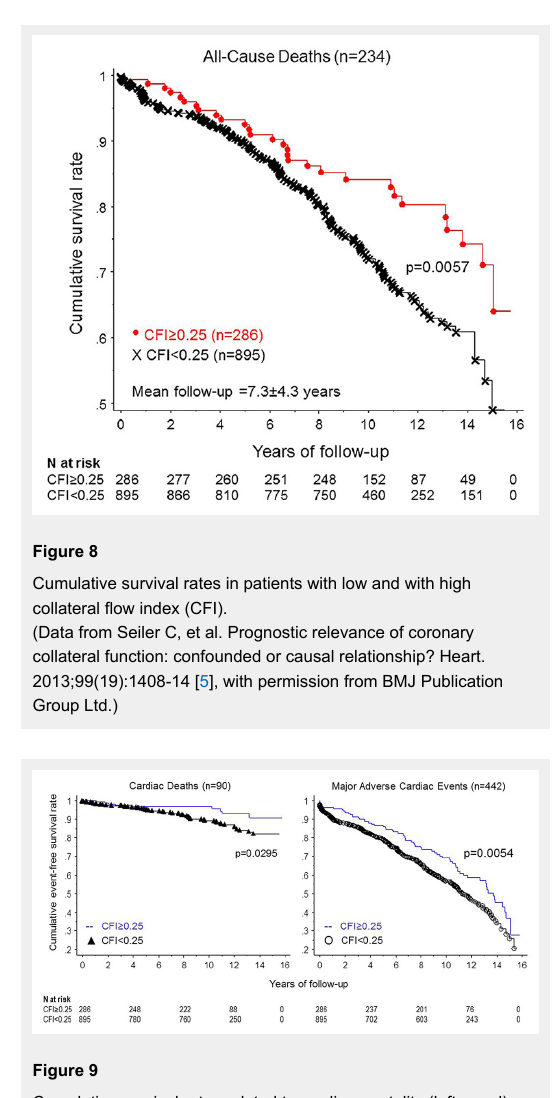
Cumulative survival rates related to cardiac mortality (left panel) and to major adverse cardiac events (right panel) in patients with low and with high collateral flow index (CFI). (Data from Seiler C, et al. Prognostic relevance of coronary collateral function: confounded or causal relationship? Heart. 2013;99(19):1408-14 [5], with permission from BMJ Publication Group